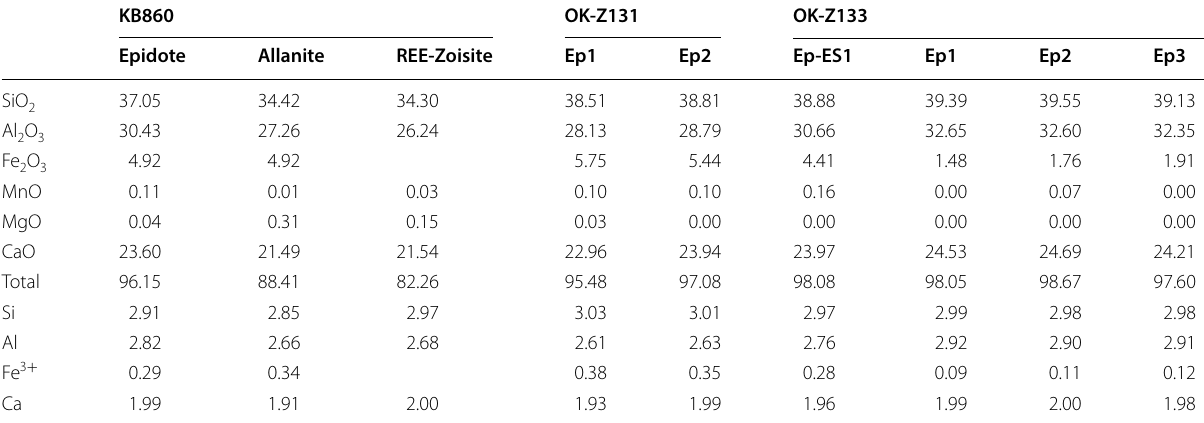
Epidote rim Euhedral overgrowth on corroded REE-rich allanite (core). REE-zoisite = Formulas normalized to 12.5 oxygen Table 12 Composition of amphibole from two samples of TGU Grt‑Ph schist